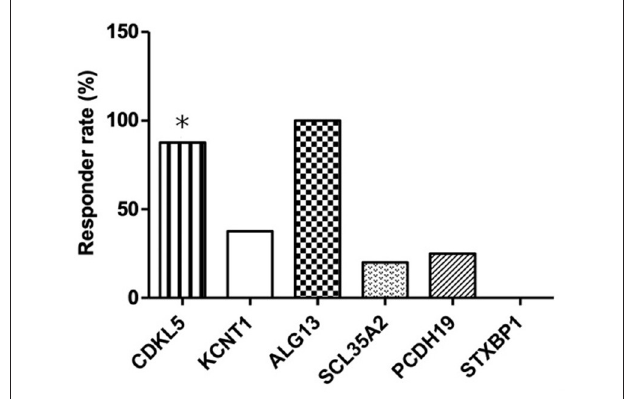
FIGURE 1 | Responder rates to 16-week KD treatment according to the identified pathogenic genetic mutations in patients with IS. *Responder rates that are significantly higher than the non-responder rate in patients with CDKL5 mutation.